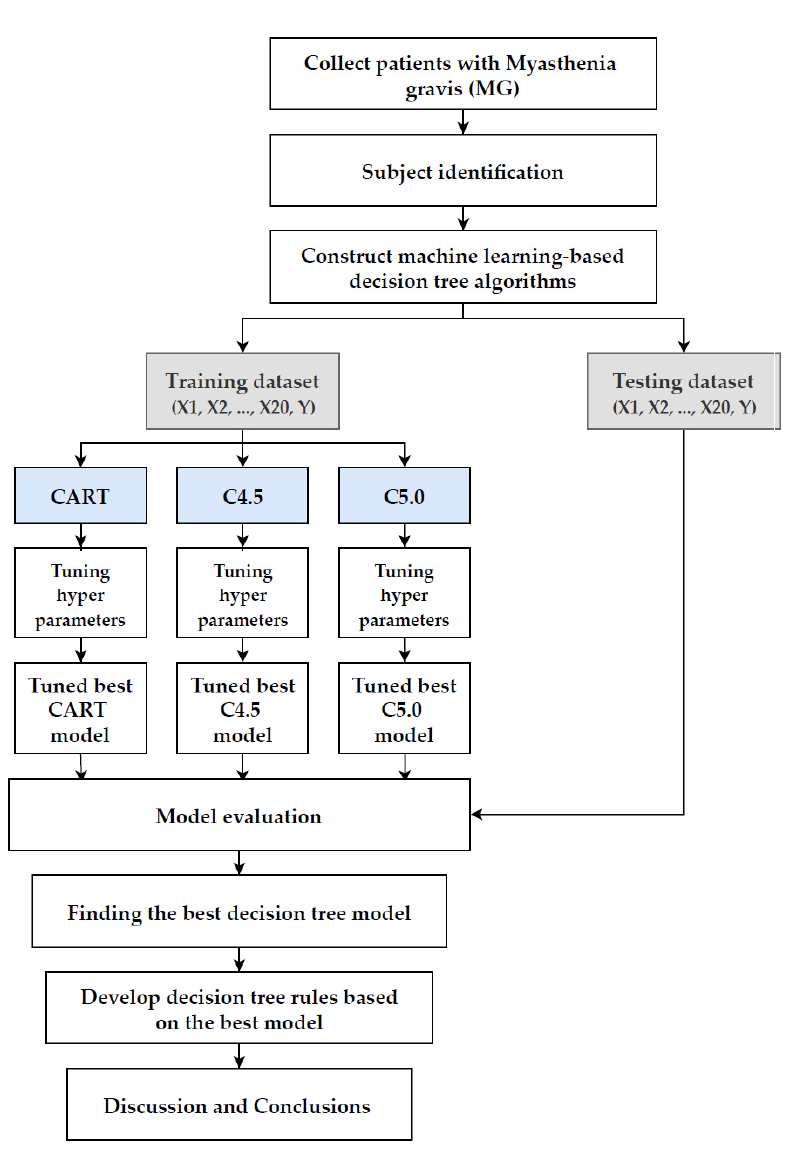
Figure 2. The overall flowchart of the proposed scheme.